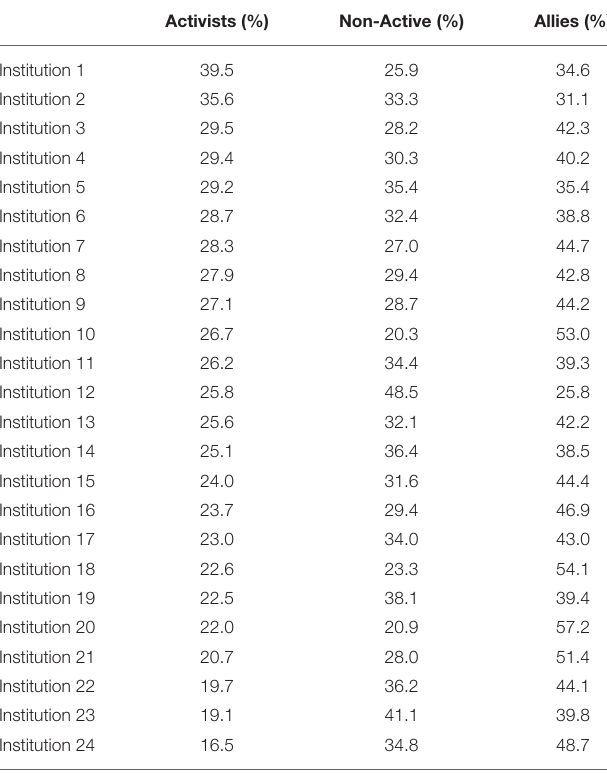
TABLE 3 | Proportions of civic engagement student groups by institution. Activists